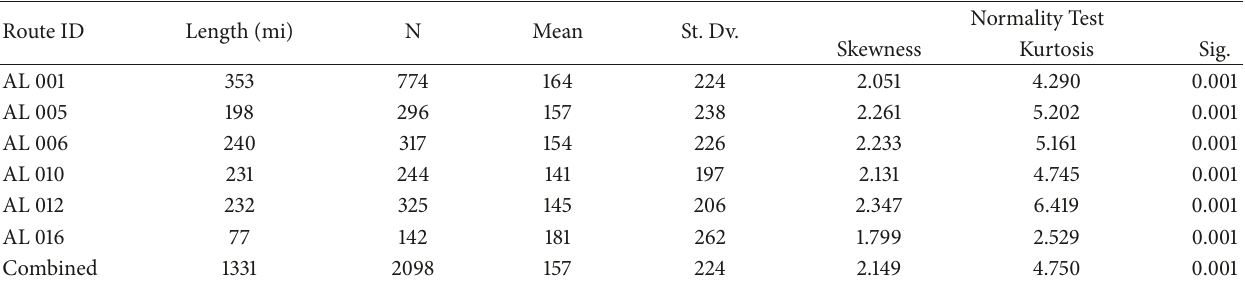
Table 3: Descriptive statistics of the nonsevere aggregate (dry and wet) crash rates and tests of normality for the ten selected routes. Route ID